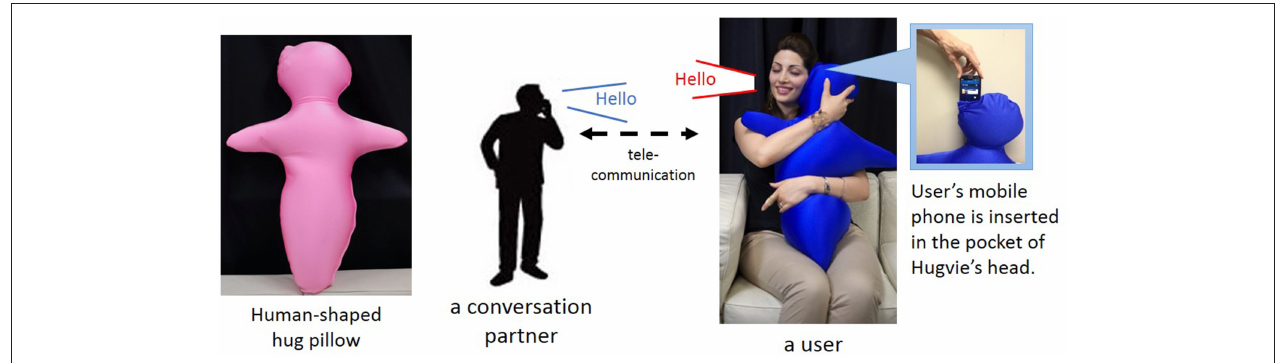
FIGURE 1 | Hugvie: huggable communication medium.